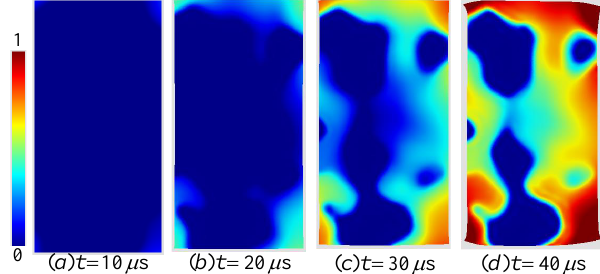
Figure 15. The evolution of damage field for the high amplitude load and cohesion realization with l c = 40 mm at times: ( a ) 13 µ s, ( b ) 23 µ s, ( c ) 33 µ s, and ( d ) 43 µ s. The results are shown on the deformed mesh with a magnification factor of 100.